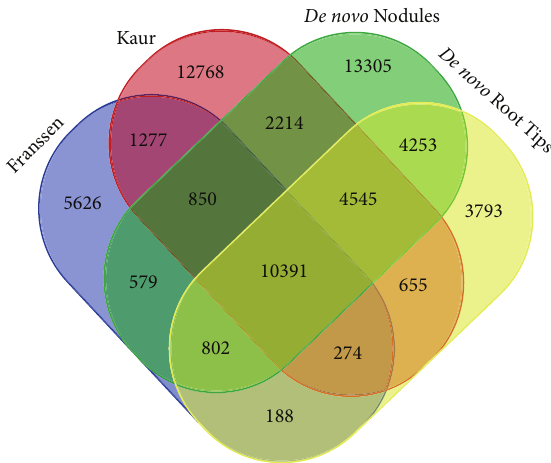
Figure 3: Clustering the sequences of the “ de novo Nodules” assembly (this study) together with pea sequences produced from nonnodular tissues (“Franssen” [13], “Kaur” [14], and “ de novo Root Tips” (this